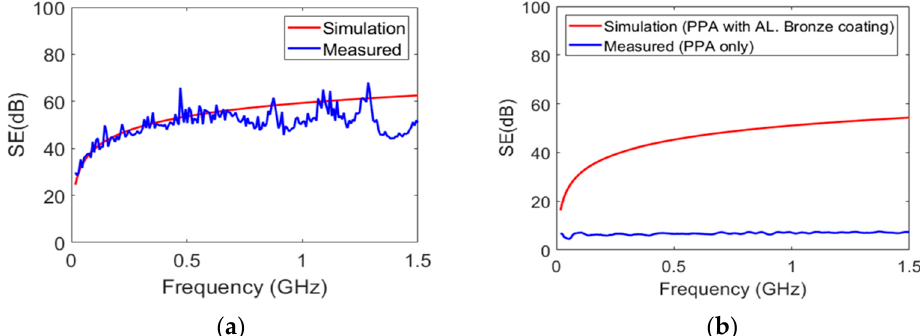
Figure 11. The EMI SE: ( a ) PPS with Zn coating; ( b ) PPA without and with aluminum bronze coating (5 µm).